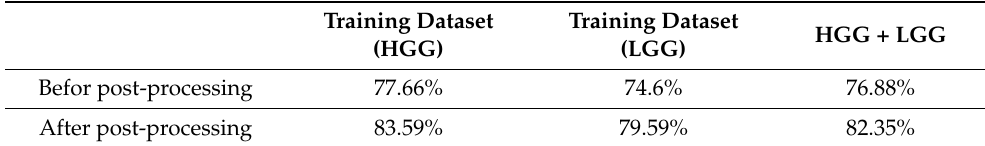
Table 5. The Dice scores of our segmentation method before and after post-processing on the BraTS 2017 training dataset.